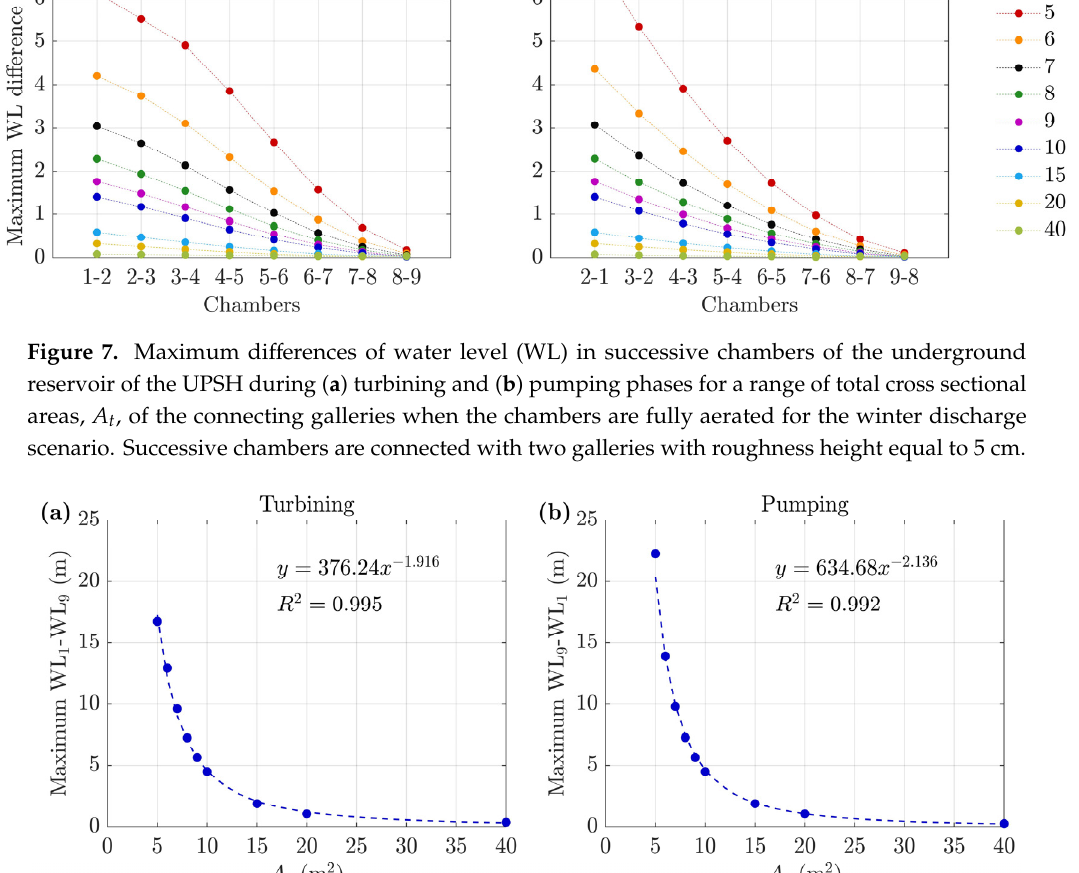
Figure 8. Maximum difference of water level (WL) between chambers 1 and 9 during ( a ) turbining and